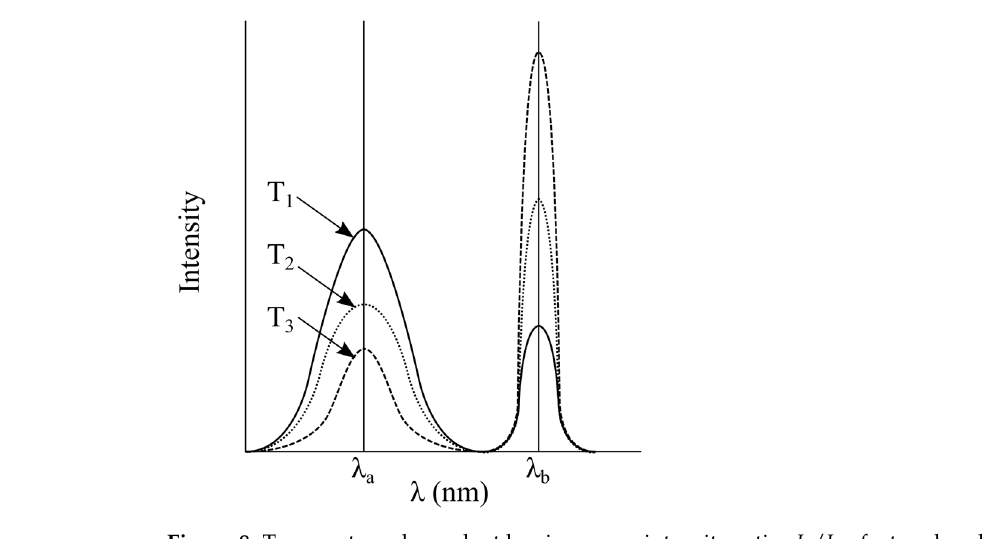
Figure 8. Temperature-dependent luminescence intensity ratios I a / I b of a two-band emitting system where T 1 > T 2 > T 3 .